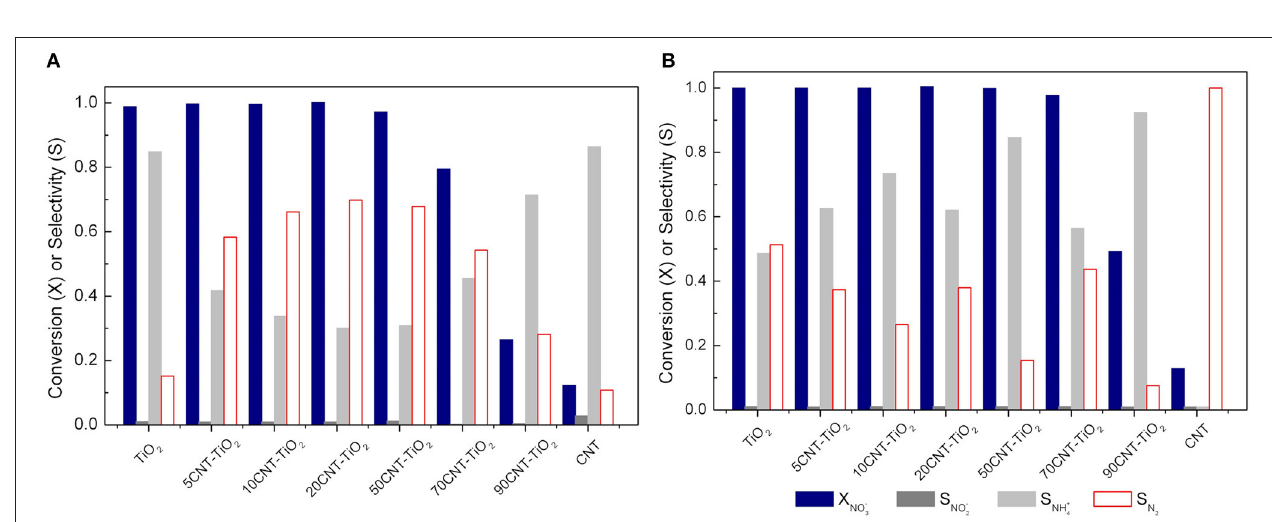
) and nitrite, ammonium and nitrogen selectivity ( S NO 3 −